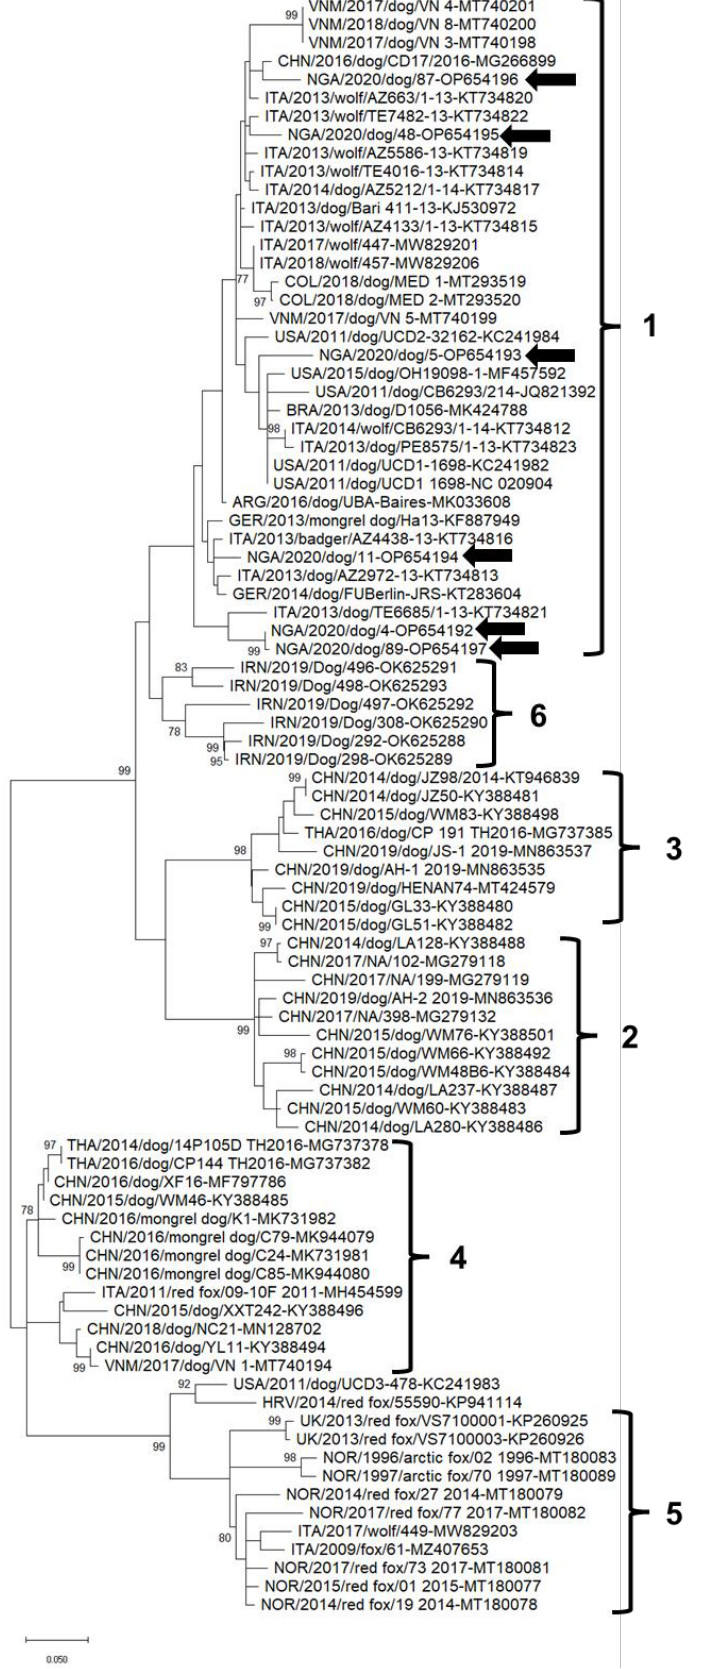
Figure 3. Phylogenetic tree based on the partial replicase sequence (307 nt) of dog circovirus